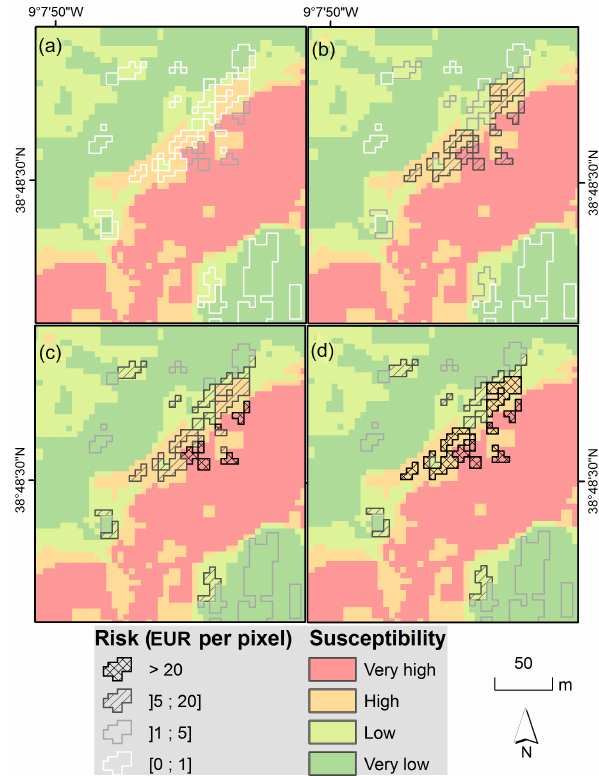
Figure 16. Detail of multiannual risk for buildings of the Loures municipality located on a landslide body with a 10m deep slip sur- face, for a hazard of (a) 1 year, (b) 10 years, (c) 25 years, and (d) 50 years. Pixel size: 5m. For location, see Fig.